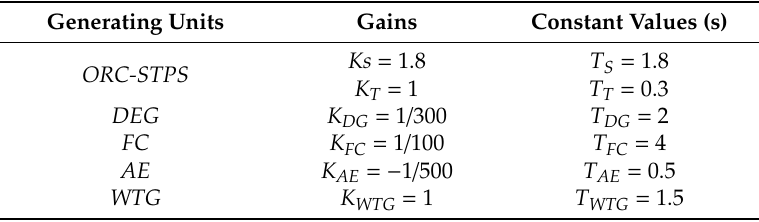
Figure 1. Topology of the proposed microgrid (( a ) the top) and the transfer function diagram of the proposed model (( b ) the bottom). Table 1. Proposed hybrid energy model parameters